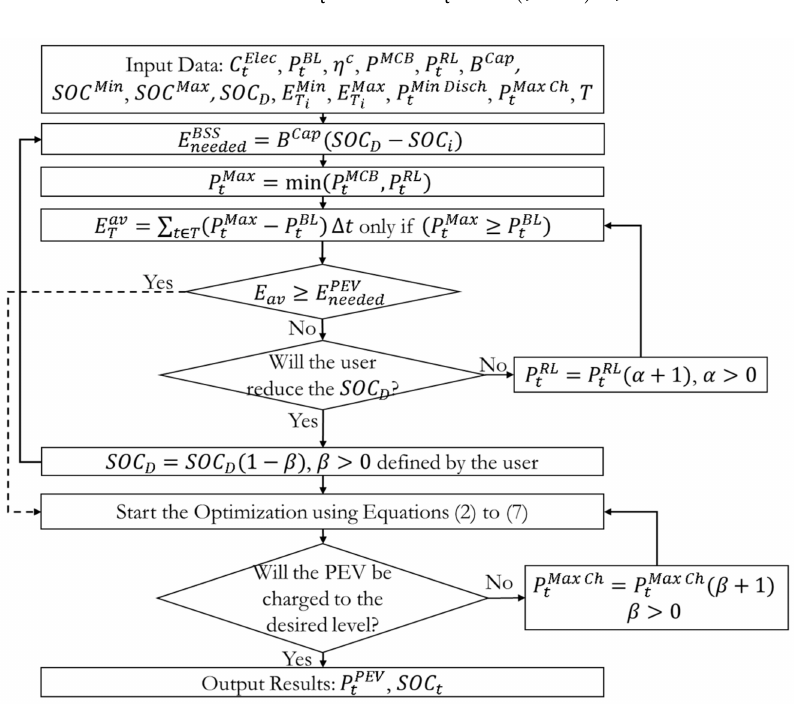
Figure 1. Proposed algorithm to schedule the charging of PEVs.